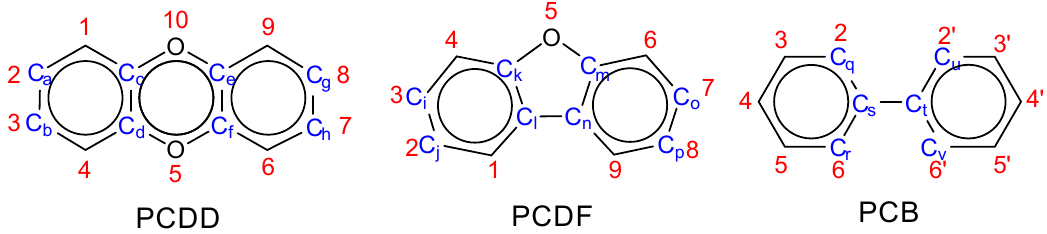
Figure 1. Substitution position numberings (in red) and selected carbon atoms for dihedral angle calculation (in blue) for PCDDs, PCDFs, and PCBs.